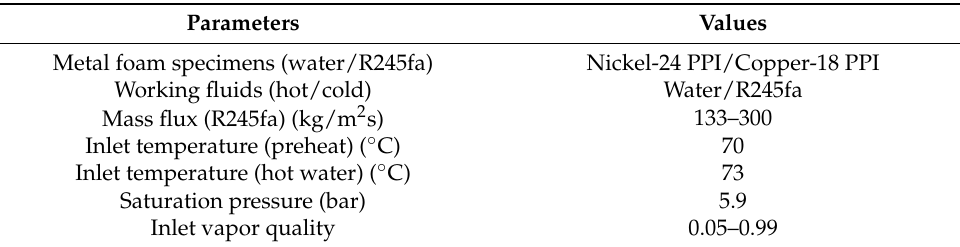
Table 3. Experimental